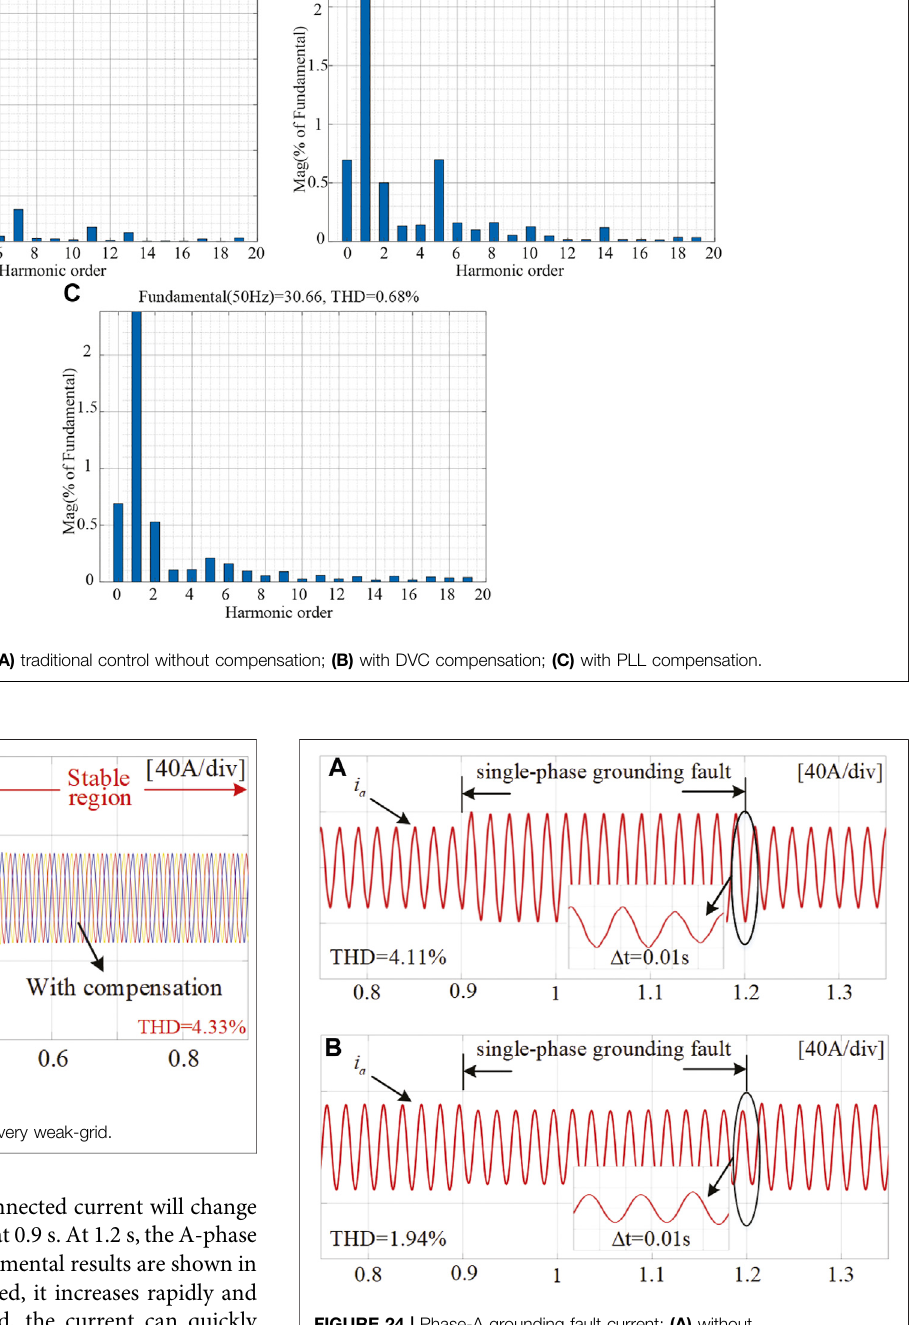
FIGURE 24 | Phase-A grounding fault current; (A) without compensation; (B) with